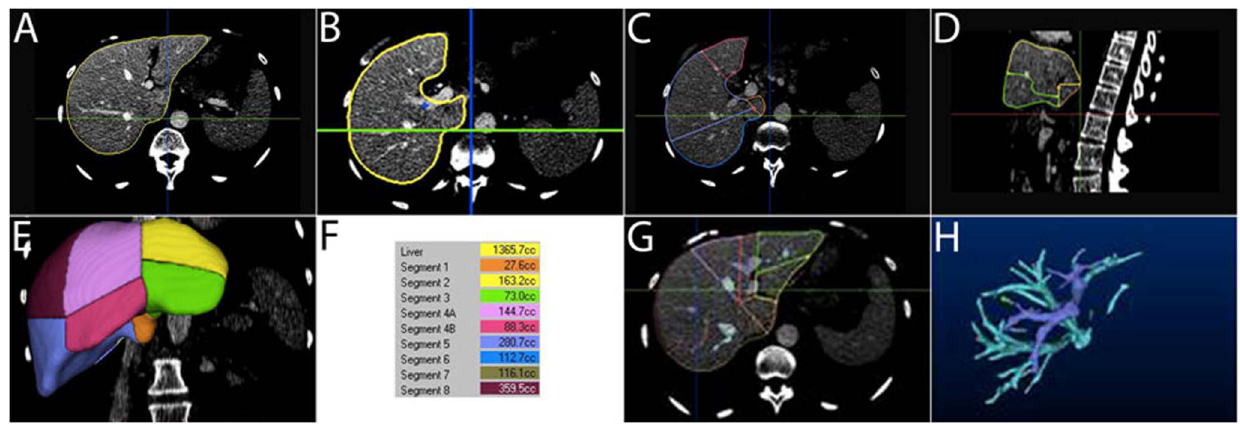
Figure 5. Semi-automated Interactive Software (P) – Image Example. A Transverse image of the portal-venous phase – automated outline of the entire liver after manual correction of false-positive and false-negative extractions. B Manual positioning of the anatomical landmark ‘‘first bifurcation of the right portal vein’’ (blue circle) according to Fig. 1A. C Automated definition of segments of Couinaud for right liver - transverse image. D Automated definition of segments of Couinaud for left liver - sagittal image. E Volume rendering (coronal view) with automated definition of segments of Couinaud of the entire liver. F List of volumes for the different segments of Couinaud. G Transverse image of the portal-venous phase – automated outline of the entire liver after manual correction of false-positive and false-negative extractions. H Volume rendering (coronal view) with automated definition of vessels (liver veins in light blue and portal veins in dark blue). Note: in each live liver donor, CT-volumetry of the entire liver was performed to ensure that the postoperative liver volume, calculated on the basis of Fig. 5F, is